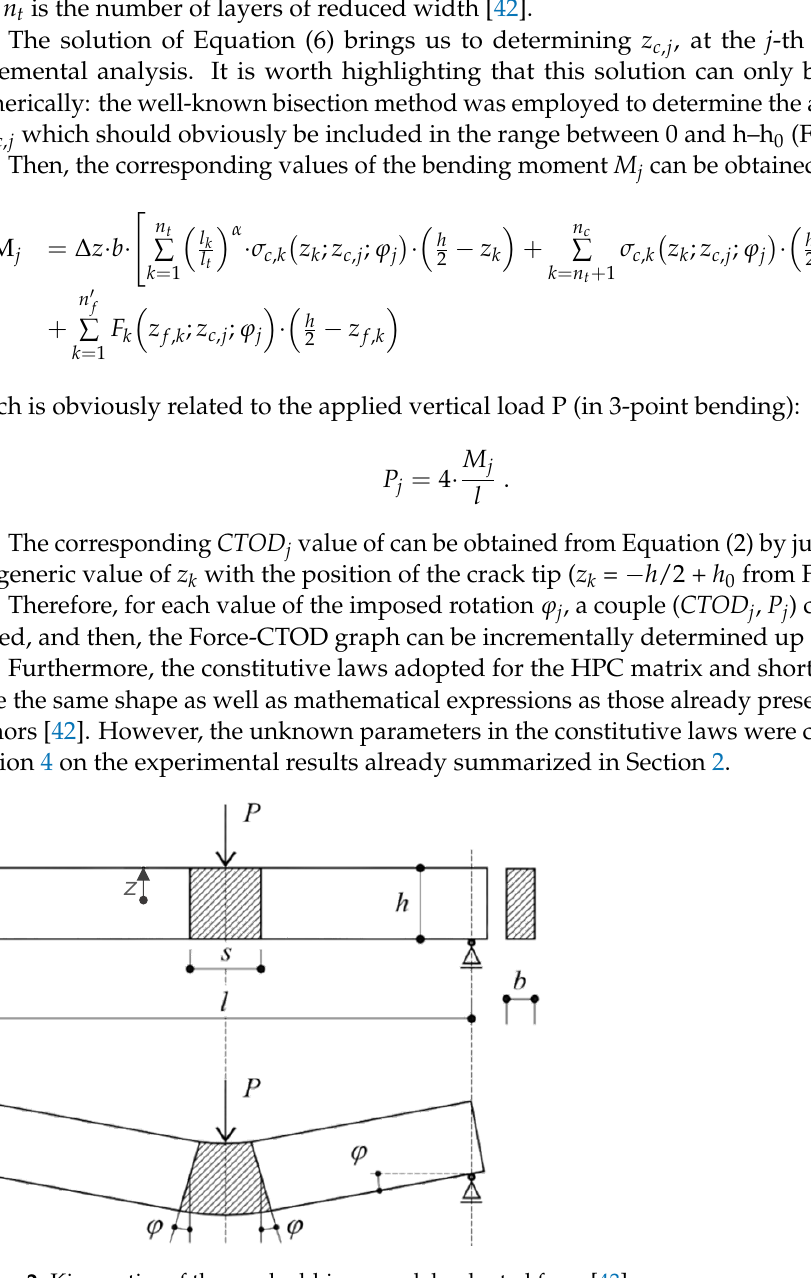
Figure 2. Kinematics of the cracked-hinge model: adapted from [43].